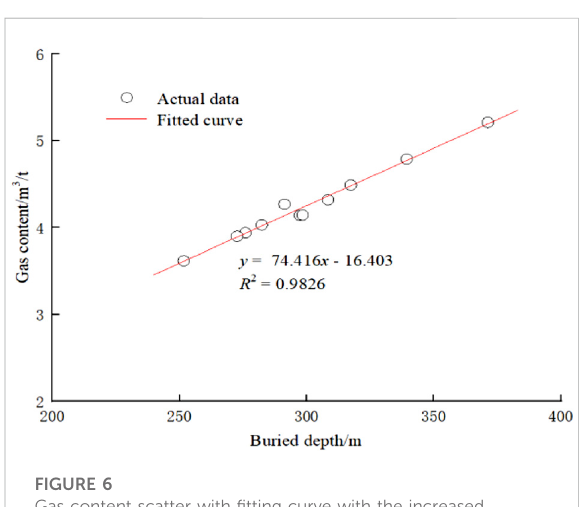
FIGURE 6 Gas content scatter with fi tting curve with the increased buried depth in district